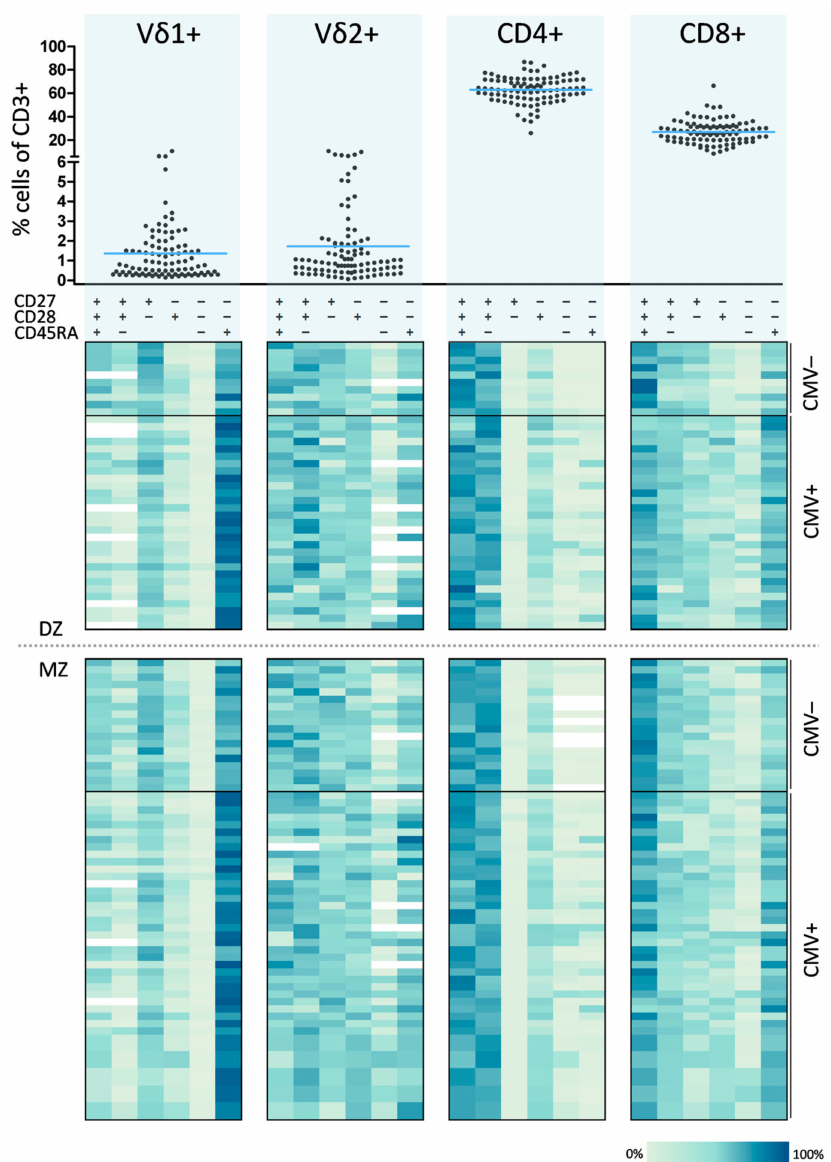
Figure 1. Peripheral frequencies of γδ and αβ T cell subsets and distribution of corresponding differentiation phenotypes. Frequencies of V δ 1+, V δ 2+, CD4+ and CD8+ T cells within all CD3+ T cells are shown. Blue lines indicate the mean for each group. Heat maps illustrate the differentiation signatures for each subset based on the combined expression of CD27, CD28 and CD45RA. Each line represents a single individual across all four T cell subsets, and each row presents a defined differentiation T cell phenotype. Frequencies for each phenotype are color-coded. The upper heat maps represent dizygotic (DZ), the lower ones monozygotic (MZ) twins. Within each heat map subjects are grouped by cytomegalovirus (CMV) serostatus. +, positive for the respective feature; –, negative for the respective